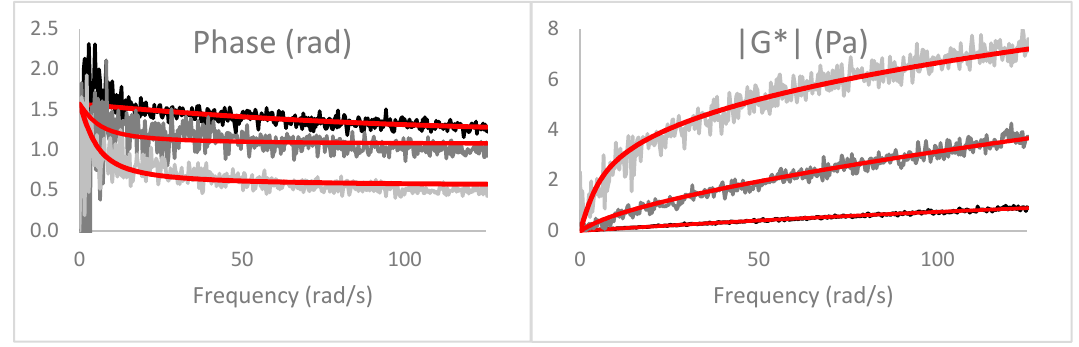
- - - Figure 13. Experimental frequency response for EVA near the melting point, at 79 ° C Figure 13. Experimental frequency response for EVA near the melting point, at 79 ° C - Figure 13. Experimental frequency response for EVA near the melting point, at 79 ° C Figure 13. Experimental frequency response for EVA near the melting point, at 79 ° C . 64 ° C . 64 ° C . 64 ° C . 64 ° C Parameter values for phase 1 (solid) and phase 2 (liquid) are presented in Tables 3 and 4, Parameter values for phase 1 (solid) and phase 2 (liquid) are presented in Tables 3 and 4, Parameter values for phase 1 (solid) and phase 2 (liquid) are presented in Tables 3 and 4, respectively. respectively. Table 3. EVA elastic to Kelvin Voigt transition. Table 3. EVA elastic to Kelvin Voigt transition. Table 3. EVA elastic to Kelvin Voigt transition. Table 3. EVA elastic to Kelvin Voigt transition. EL–KV EL–KV EL–KV EL–KV